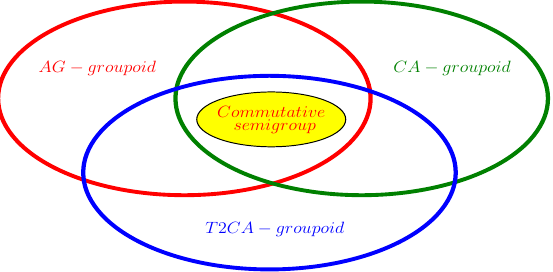
Figure 1. The relationships among the AG-groupoid, CA-groupoid and T2CA-groupoid. In Figure 1, there are three large colored oval circles and a small yellow ellipse. The large oval circles of different colors represent different groupoids. The red oval circle represents the AG-groupoid, the green oval circle represents CA-groupoid; the blue oval circle represents the T2CA-groupoid; and the small yellow one at the intersection of the three large oval circles represents the commutative semigroup. From Figure 1, we can see that the commutative semigroup is indeed a special kind of groupoid which not only satisfies the left invertive law but also satisfies the cyclic associative law and the type-2 cyclic associative